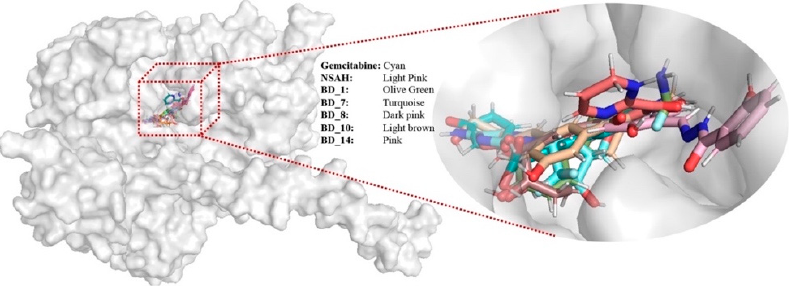
19 of 35 Figure 4. Binding interaction profile of top five molecules, gemcitabine, and NSAH. From the binding interaction analyses, it was found that SER202 and GLU431 were found to establish HB interactions in gemcitabine, BD_7, and BD_8. Similarly, SER448 was also found to interact with gemcitabine, BD_7, and BD_10. It is important to note that THR607 was found to interact with gemcitabine and all five proposed hRRM1 inhibitors. Both ALA201 and THR604 were seen to form hydrophobic contacts with gemcitabine, BD_7, and BD_10. The amino acids residue ALA245 was found to interact with both NSAH and BD_14. Hence, it was undoubtedly clear that all the five proposed molecules were found to show almost a similar binding interaction pattern in molecular docking simulation. From the analysis of the binding interaction, it was very clear that all proposed mol- ecules perfectly occupied the biologically relevant active site of hRRM1. For better obser- vation, the surface view of all hRRM1 molecules including gemcitabine and NSAH was